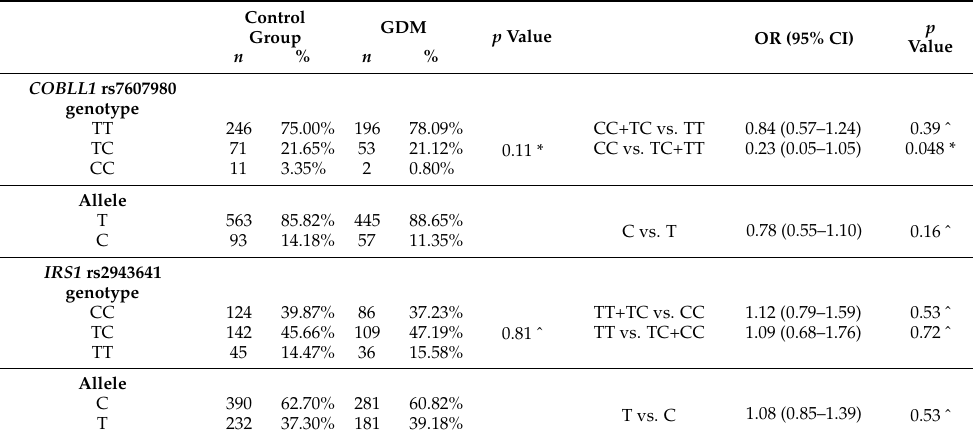
Table 1. Distribution of COBLL1 rs7607980 and IRS1 rs2943641 genotypes and alleles in women with GDM and the control group.